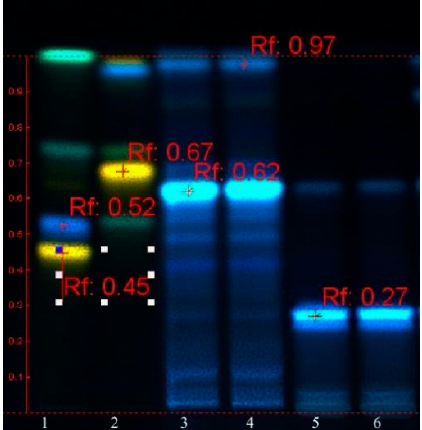
Figure 1. HPTLC fingerprint of polyphenols in Helleborus samples. Track 1: reference substances ( Rf ≈ 0.45 — rutin, Rf ≈ 0.52—chlorogenic acid); track 2: Rf ≈ 0.67—hyperoside; tracks 3 and 4: H1 (duplicate); tracks 5 and 6: H2 (duplicate).